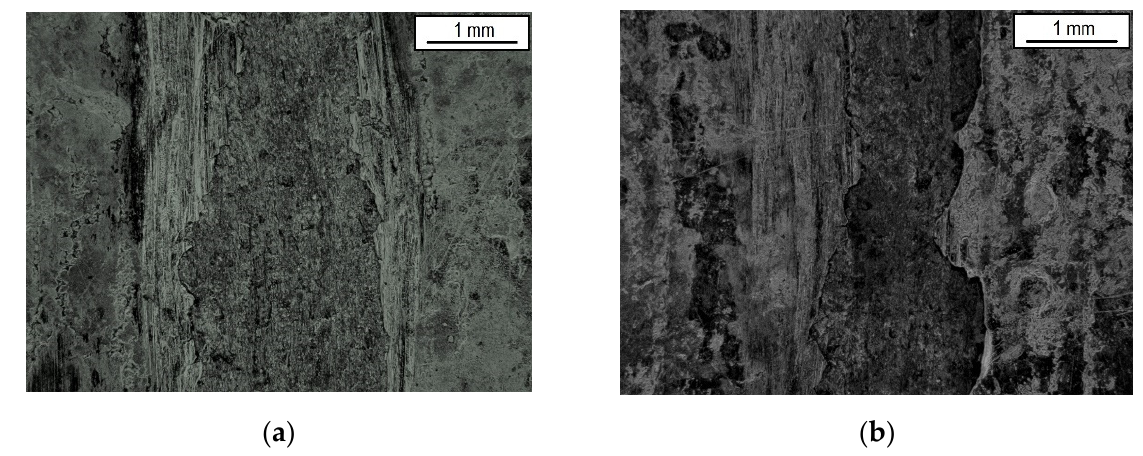
Figure 8. The macrostructure of the analyzed coatings after friction tests: ( a ) Group 1, ( b ) Group 2.